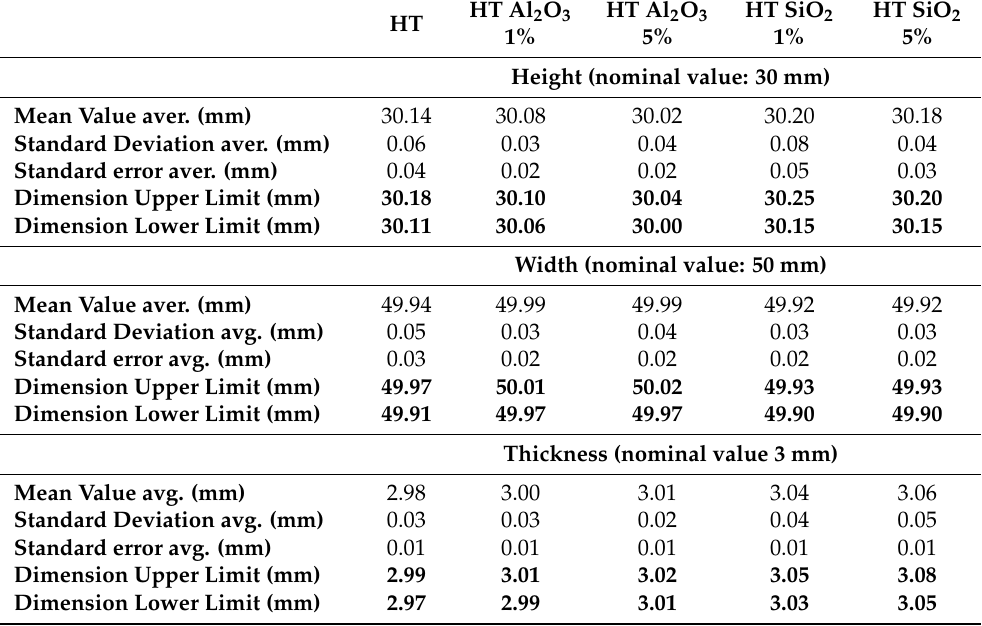
Table 2. Tolerance analysis of basic dimensions of specimens fabricated with different hybrid ceramic